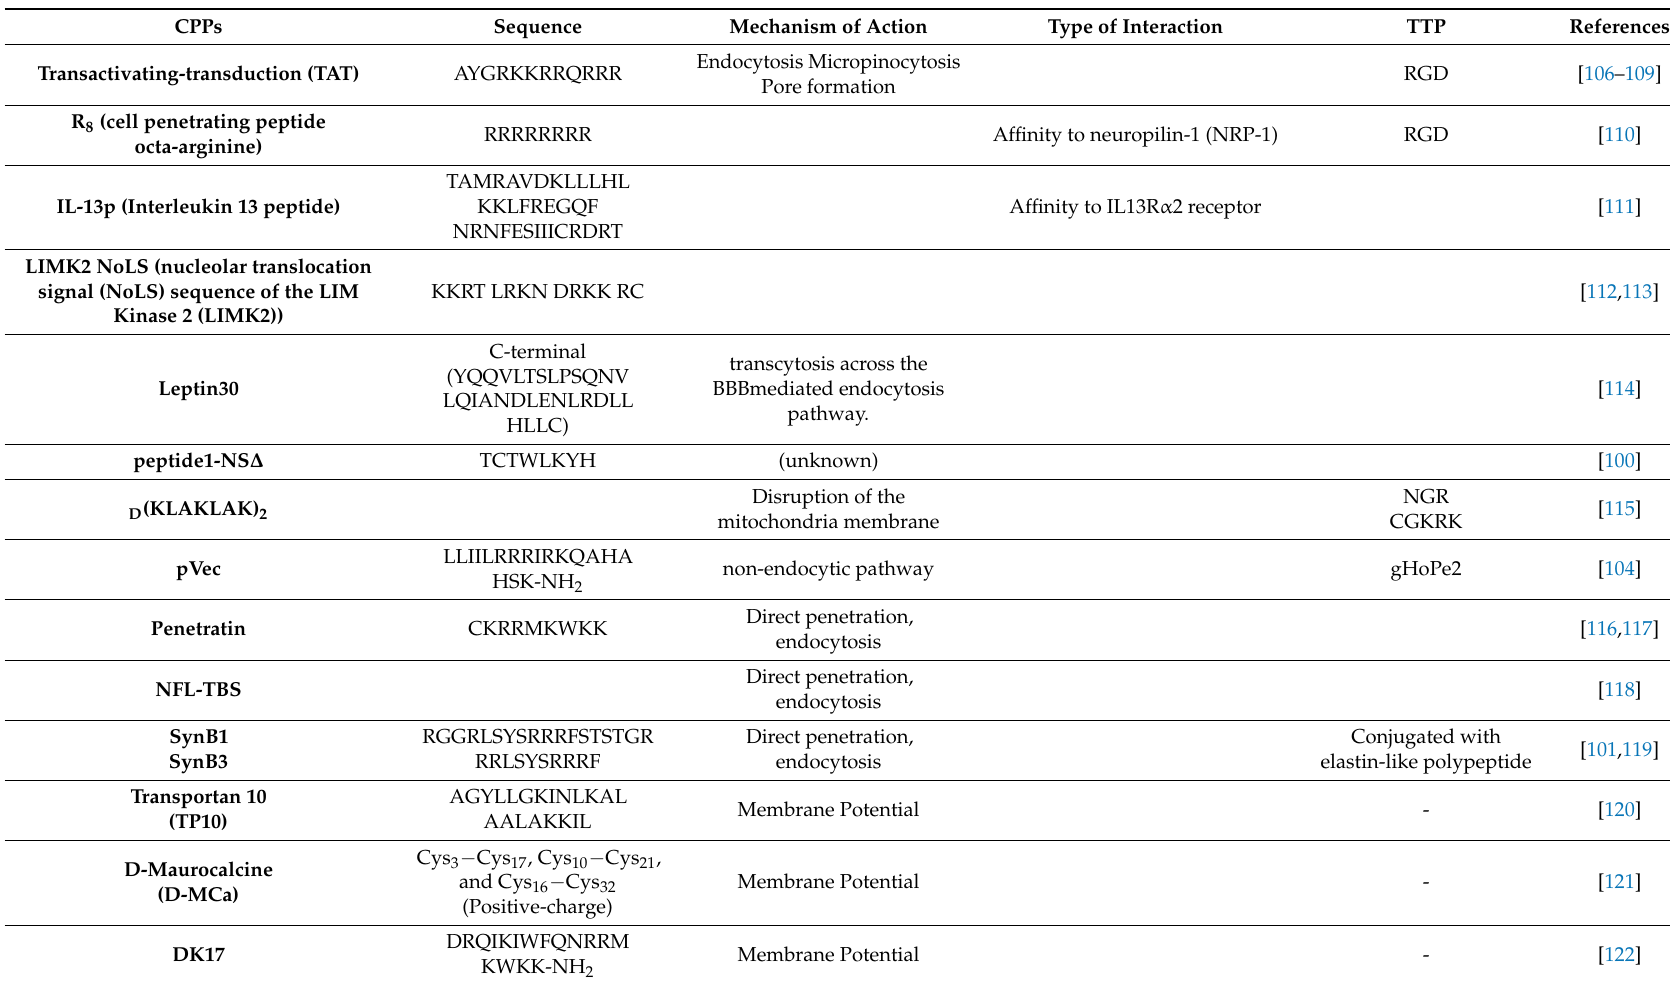
Table 3. Cell penetrating peptides described in the literature for the application on glioblastoma